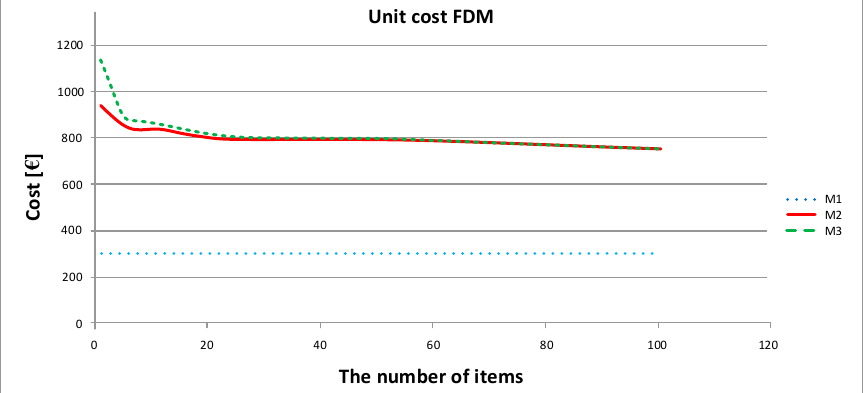
Figure 10. Dependence of the rotor production costs on the number of prototypes for FDM technology.